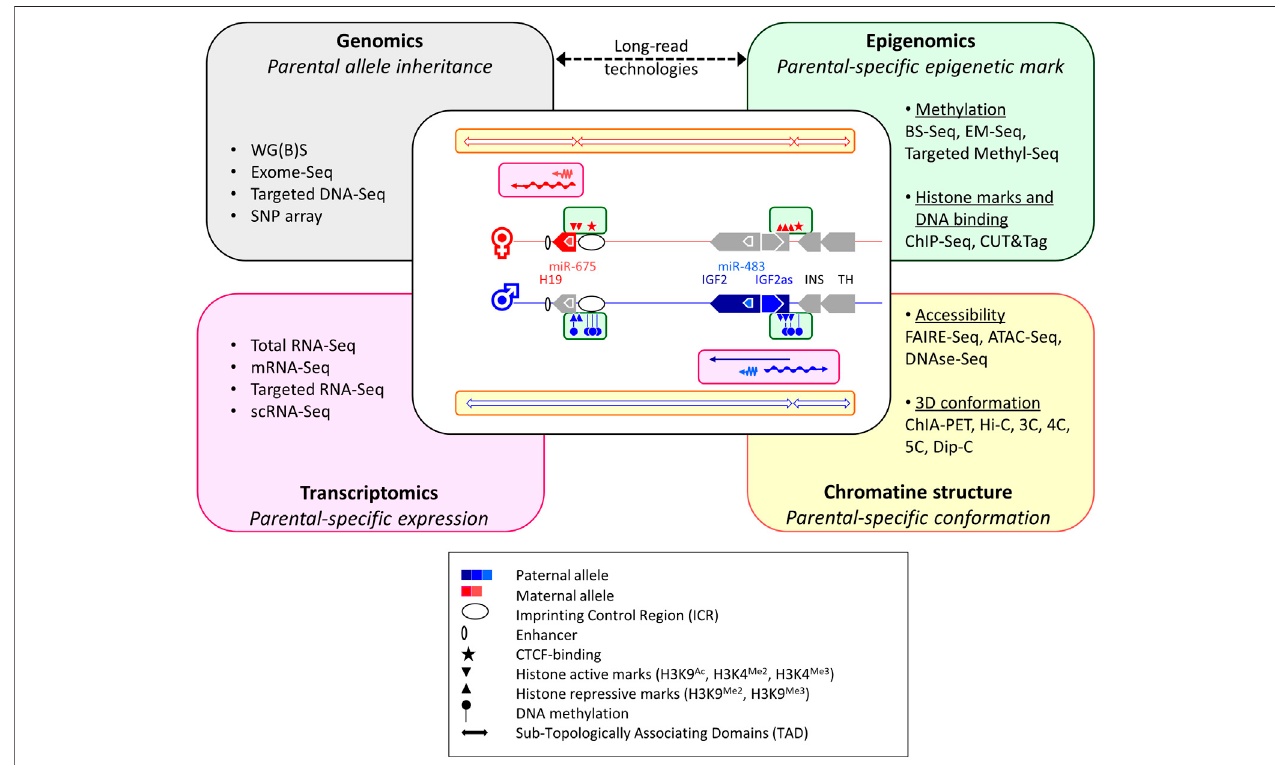
FIGURE 2 | How multi-omics nurse knowledge on genome imprinting mechanisms. The diagram in the center of the fi gure depicts the different layers of GI regulation that can be targeted using current multi-omics, through the canonical example of the Igf2/H19 imprinted cluster. The colored boxes used in the central diagram(green,pinkandyellow)representthedifferentinteractinglevelsofimprintingregulationsthatarementionedinthecorrespondingomicsboxes.WG(B)S:Whole- Genome Bisul fi te Sequencing; BS-Seq: BiSul fi te-Sequencing; EM-Seq: Enzymatic Methyl-Sequencing; ChIP-Seq: Chromatin ImmunoPrecipitation followed by Sequencing; CUT&Tag: Cleavage Under Targets and Tagmentation; scRNA-Seq: single-cell RNA-Seq; FAIRE-Seq: Formaldehyde-Assisted Isolation of Regulatory Elements Followed by Sequencing; ATAC-Seq: Assay for Transposase-Accessible Chromatin with high-throughput Sequencing; ChIA-PET: Chromatin Interaction Analysis with Paired-End Tag sequencing, 3C: Chromosome Conformation Capture; 4C: 3C on Chip; 5C: 3C-Carbon Copy; HiC: High-throughput 3C; Dip-C: Diploid